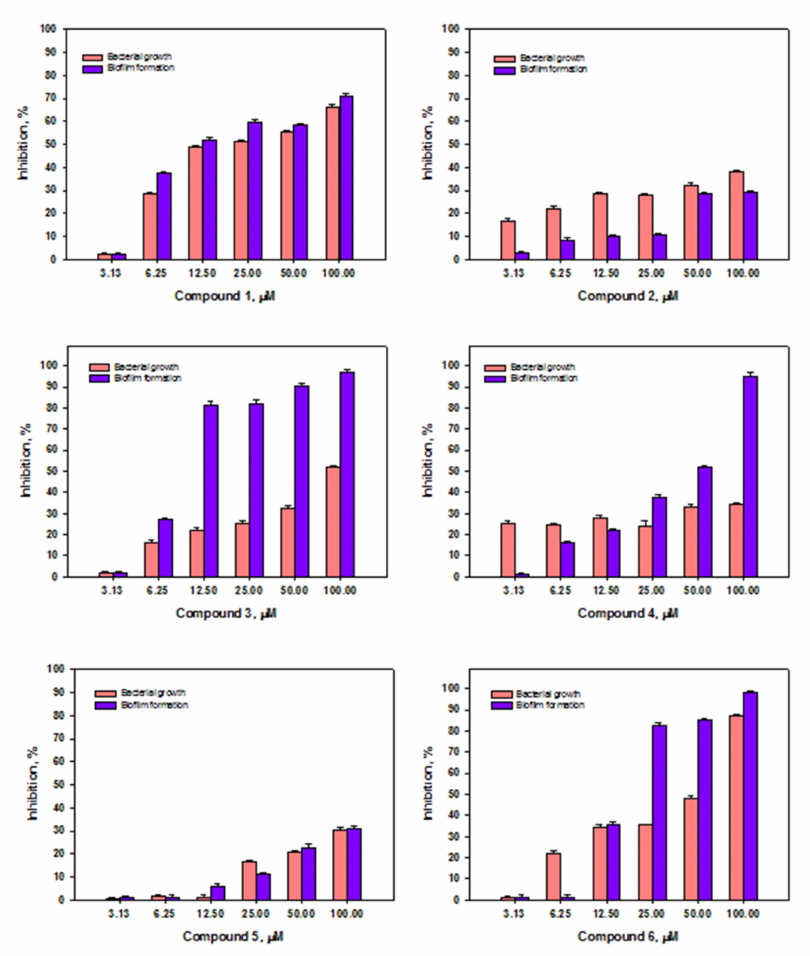
Figure 7. Effect of acrucipentyns A–F ( 1 – 6 ) on growth and biofilm formation of Staphylococcus aureus . All experiments were performed in three independent replicates and data were presented as a mean ±